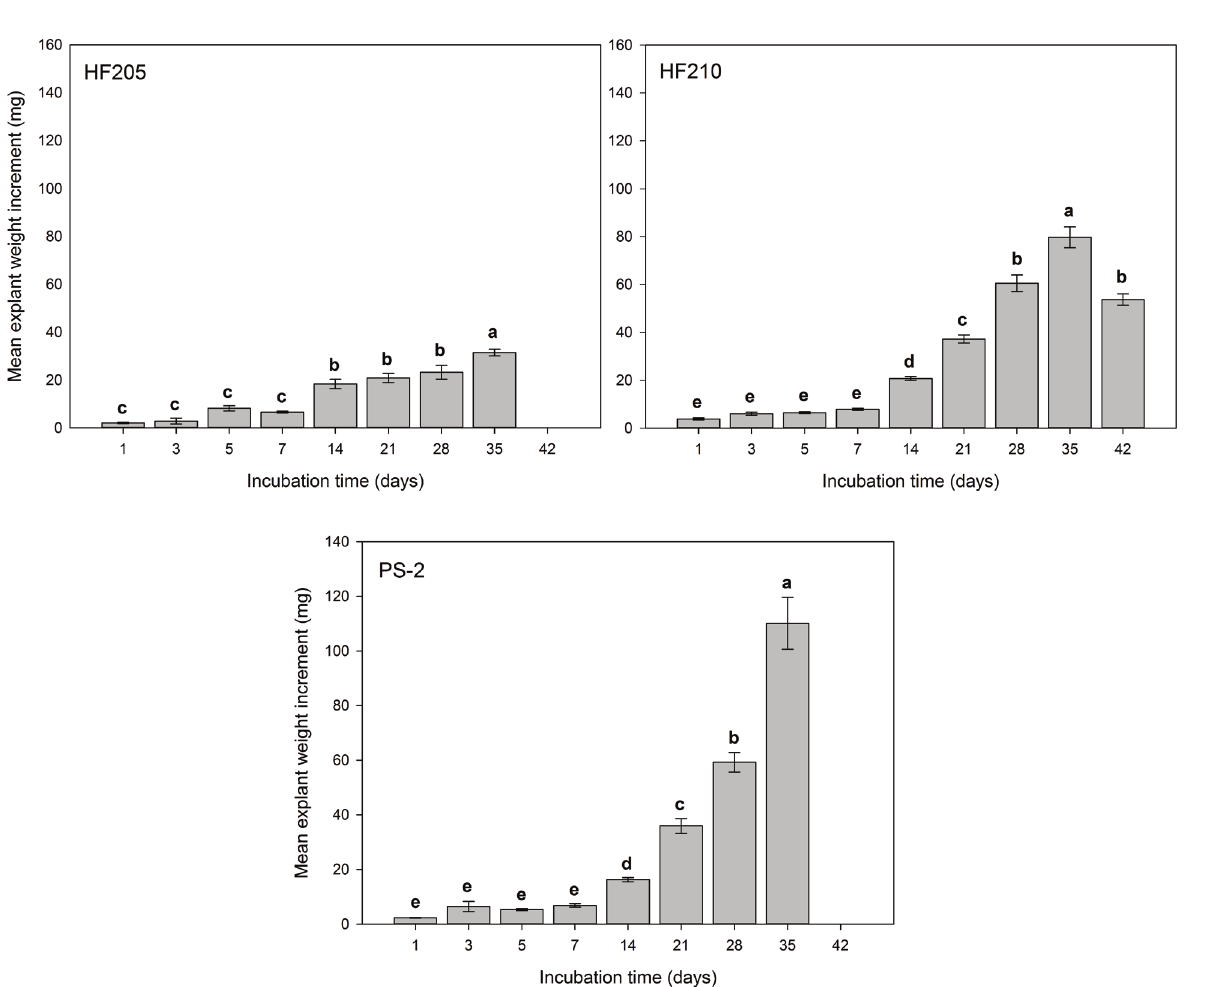
Figure 5. Mean explant weight changes (mg) over incubation times from PS-2, HF205 and HF210. After surface sterilization and dissection, inner vegetative buds from three genotypes were placed on either mDCR or mDCR+MES medium at each initial pH level (3.6, 5.1, 5.7, 6.3, and 7.8) for incubation up to 42 days. These buds were incubated in a growth chamber at 25 ° C with light regime adjusted to 16-hour light followed by 8-hour darkness each day. Bud weight change was recorded using an electronic scale when sample reached